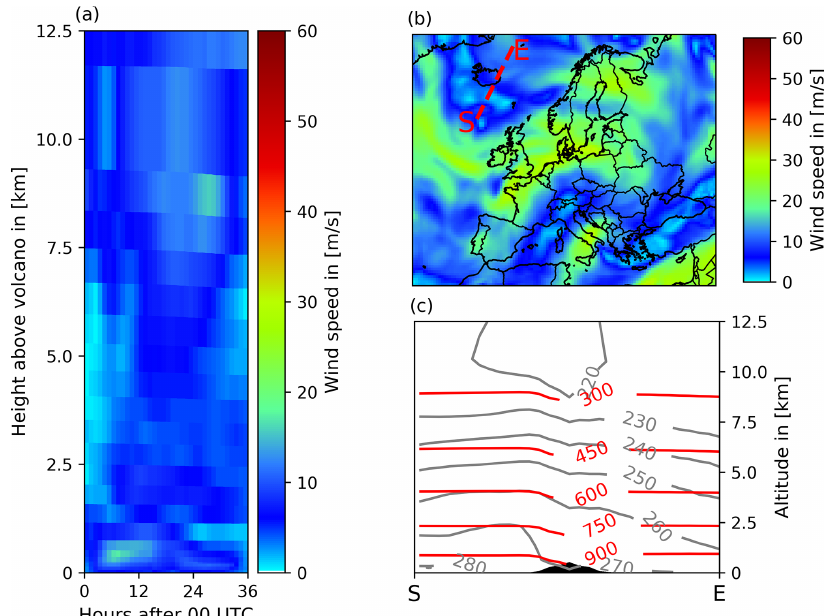
Figure 5. Meteorological conditions on 29 April 2010. (a) Wind speed above the volcano for the whole simulation period. (b) Wind speed at 500hPa on 29 April 2010, 12:00UTC, which corresponds to approx. 5km above the volcano. (c) Vertical cross section of isobars in [hPa] (red) and isotherms in [K] (gray) along the red line in (b) on 29 April 2010, 12:00UTC.